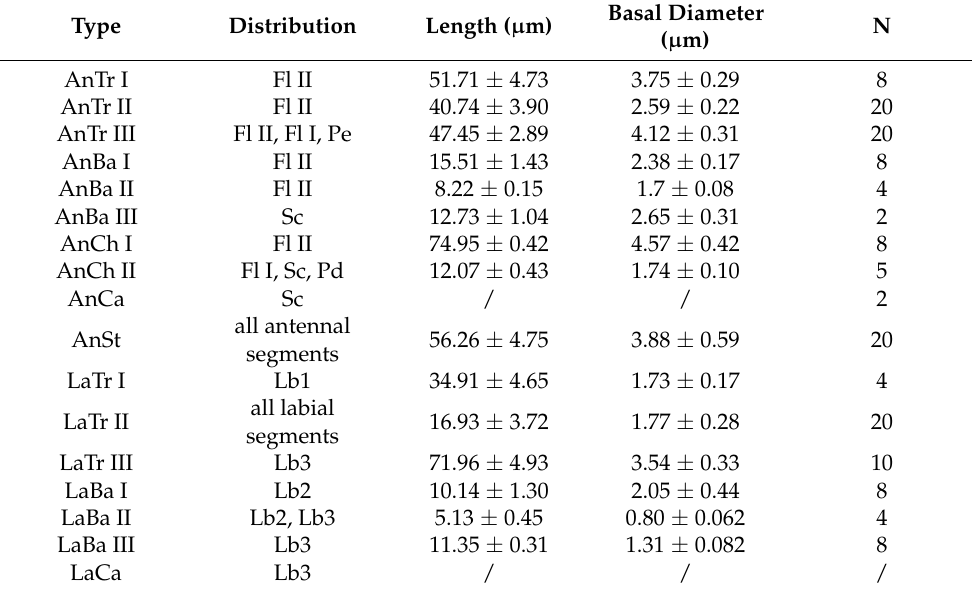
Table 2. Morphometric data of antennal and labial sensilla in Mezira yunnana (mean ±